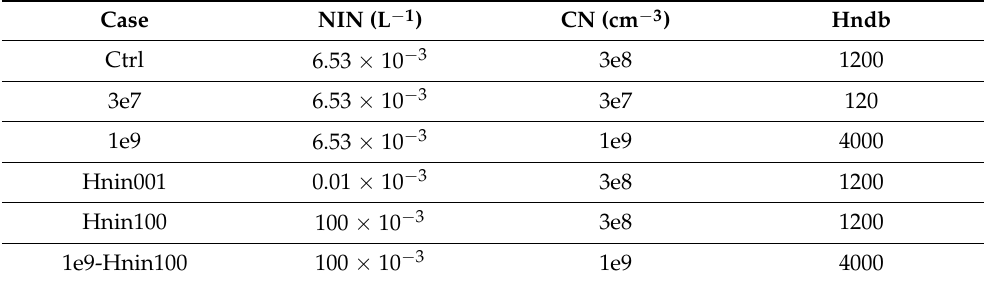
Table 3. Summary of sensitivity experiments of CN and NIN.